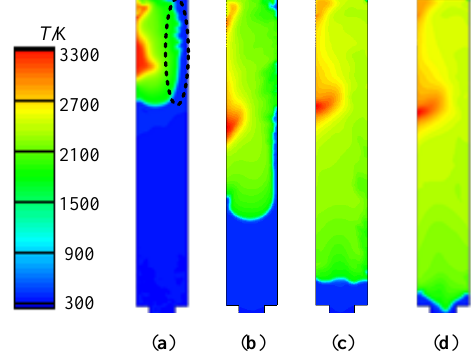
Figure 12. Variations of temperature field of the wall ignition ( a ) t HJ =0.3ms, ( b ) t HJ =0.6ms, ( c ) t HJ =0.9ms, ( d ) t HJ =1.005ms. The jet pressure also affects the jet flame propagation into the detonation chamber, so a detailed comparison of the jet pressure changes with time at the center point of the hot jet tube is shown in Figure 13. The first pressure peak appears at 0.5 ms. The pressure peak of wall ignition is 1.35 times that of top ignition. Subsequently, the pressure of wall ignition is always higher than the top ignition. The second pressure peak appears at 0.75 ms and the peak value can reach 0.2MPa. The jet flame of wall ignition enters detonation chamber with 0.1MPa at 1.005 ms, which is obviously higher than 0.06MPa of top ignition. The average pressure of the wall ignition is twice than top ignition due to more intense burning and wave superimposition. On the basis of above discussions of jet velocity, it is found wall ignition brings a faster hot jet with higher pressure. 0.0